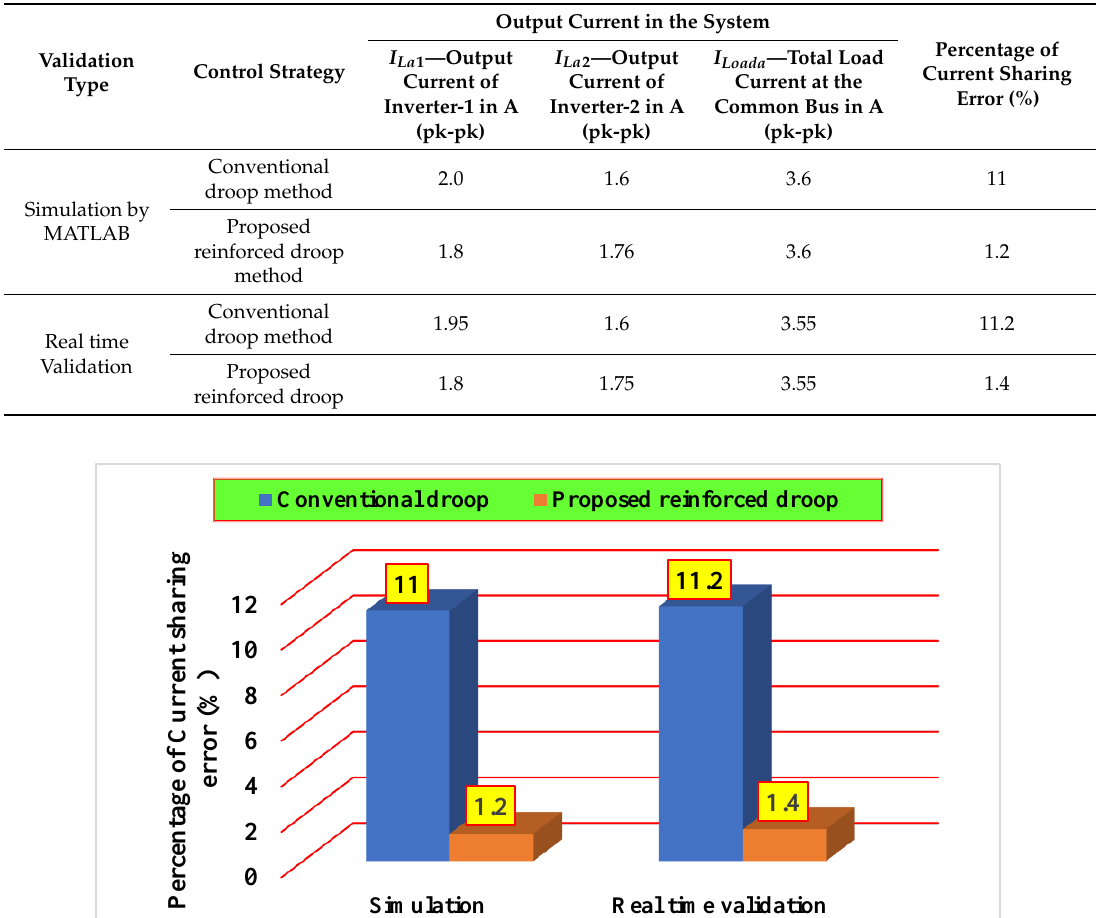
Table 3. Analysis of the conventional and proposed droop method for current sharing during parallel operation.